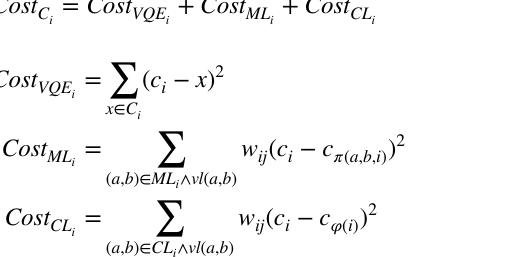
Fig. 2 Assigning a pair of constrained object ( a , b ) to clusters in CVQE+. All constraints starting and ending at a and b will be con-